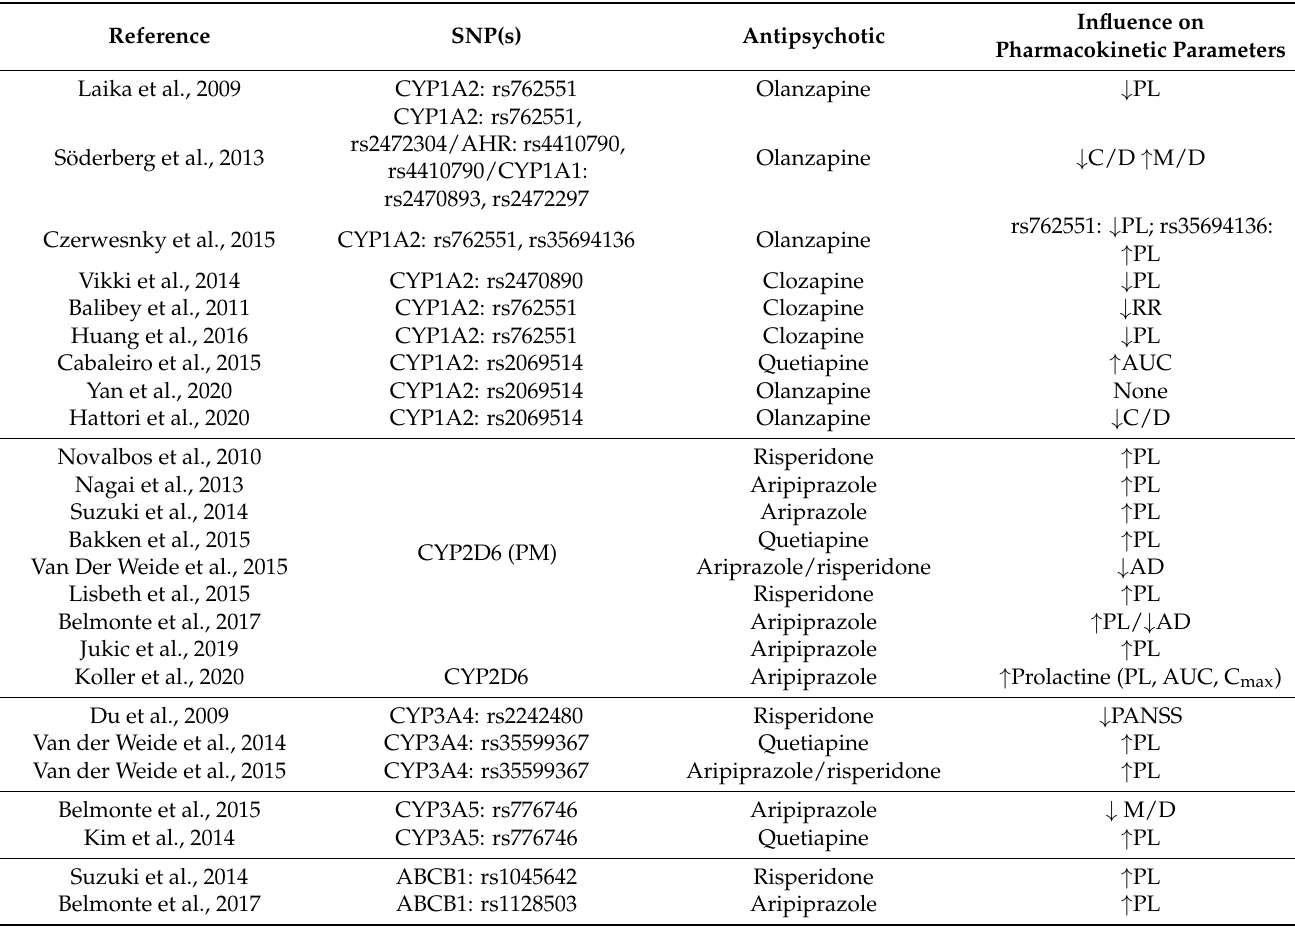
Table 2. Summary of the